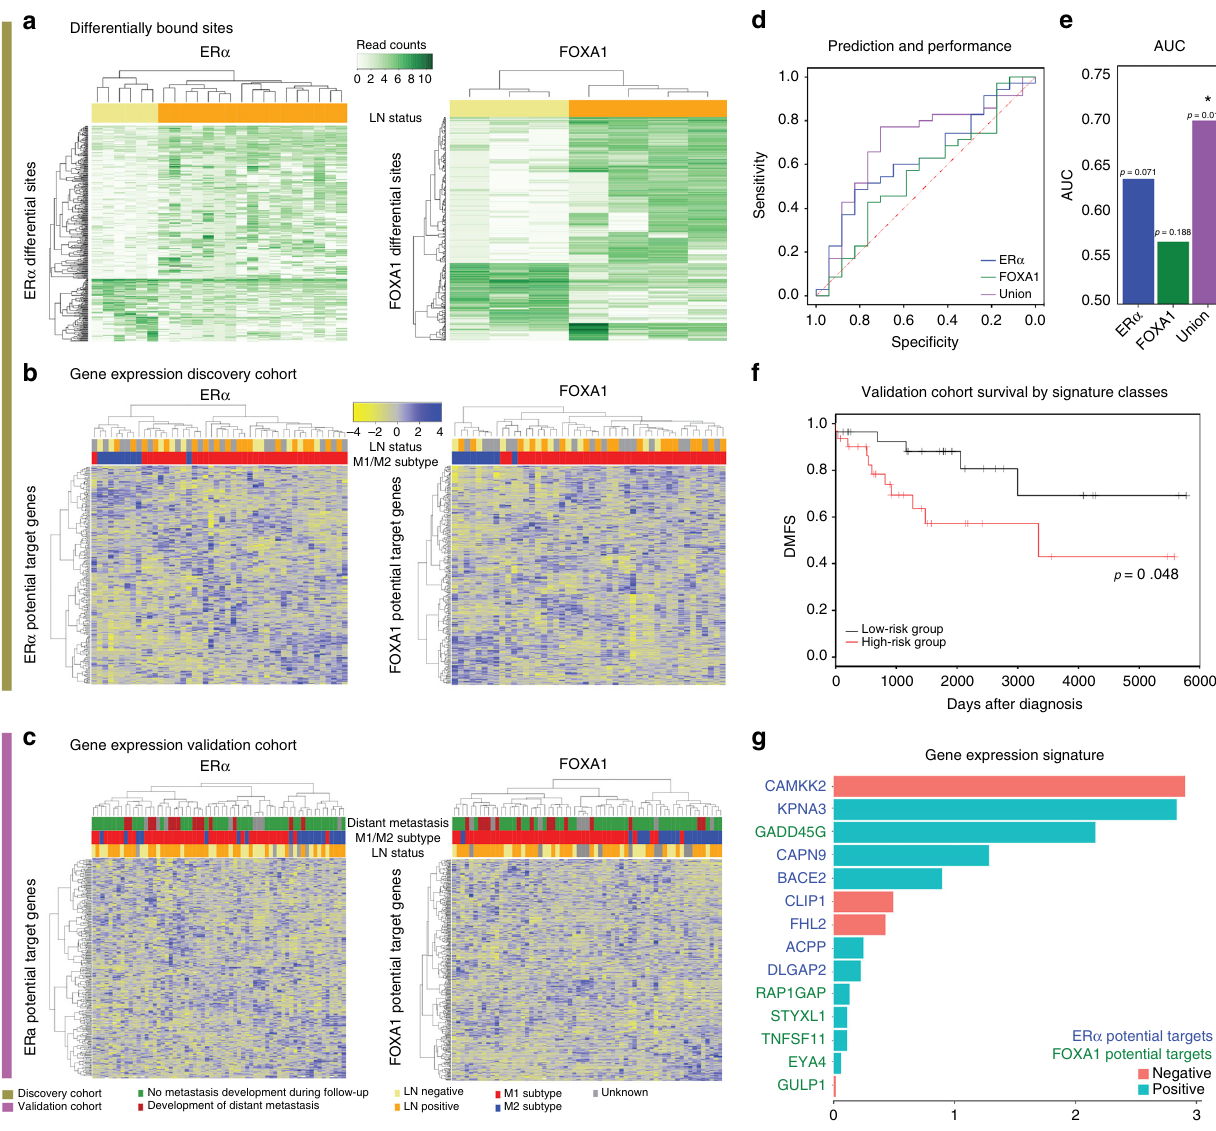
Fig. 6 Genomic selectivity of ER α /FOXA1 action classi fi es male breast cancers on outcome. a Unsupervised hierarchical clustering of ER α and FOXA1 peak intensities at sites that classify on negative (yellow) or positive (orange) LN-status. b Unsupervised hierarchical clustering of the potential target genes driven from ER α and FOXA1 binding sites that classify on LN-status (discovery cohort). Negative (yellow) and positive (orange) LN-status, M1 (red), and M2 (blue) subtypes are indicated by the color bars above. c The same analysis as in b , using the validation cohort. Negative (yellow) and positive (orange) LN-status, M1 (red) and M2 (blue) subtypes as well as development of distant metastasis (red and green) are indicated by the color bars above. d Receiver-operator characteristic (ROC) curve indicating predictive performance of binary classi fi cation models trained with potential target genes of ER α (blue), FOXA1 (green) or the union of the two (purple). e Area under curve of the ROC curves of d , with p -values from bootstrapping analysis indicated on the top of each bar. f Kaplan-Meier analysis of two groups of patients (high- and low-risk groups in red and black lines, respectively) driven from the classi fi cation model trained with union of potential targets. Difference in survival is assessed with log rank test ( p -value = 0.048). g Bar plot indicating 14 genes contributing to the classi fi cation model and their coef fi cients in the model. Predicted upstream regulator (blue − ER α and green − FOXA1) and sign of the coef fi cients (red − negative, green − positive) are